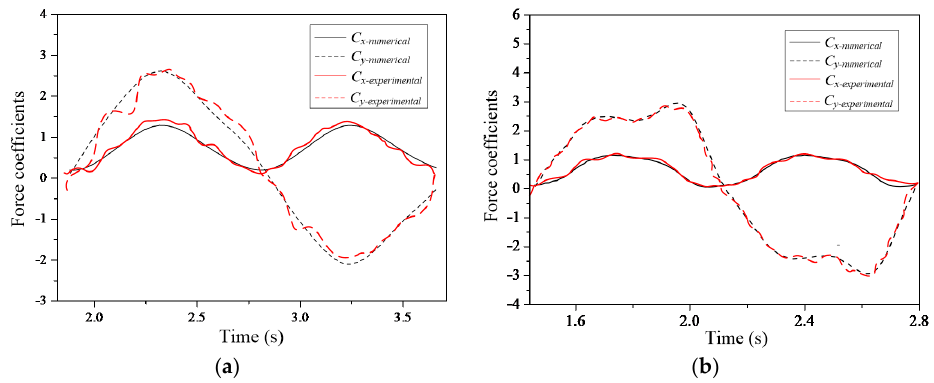
Figure 17. Comparison of experimental results and numerical results: ( a ) NACA foil; ( b ) crescent- shaped foil.